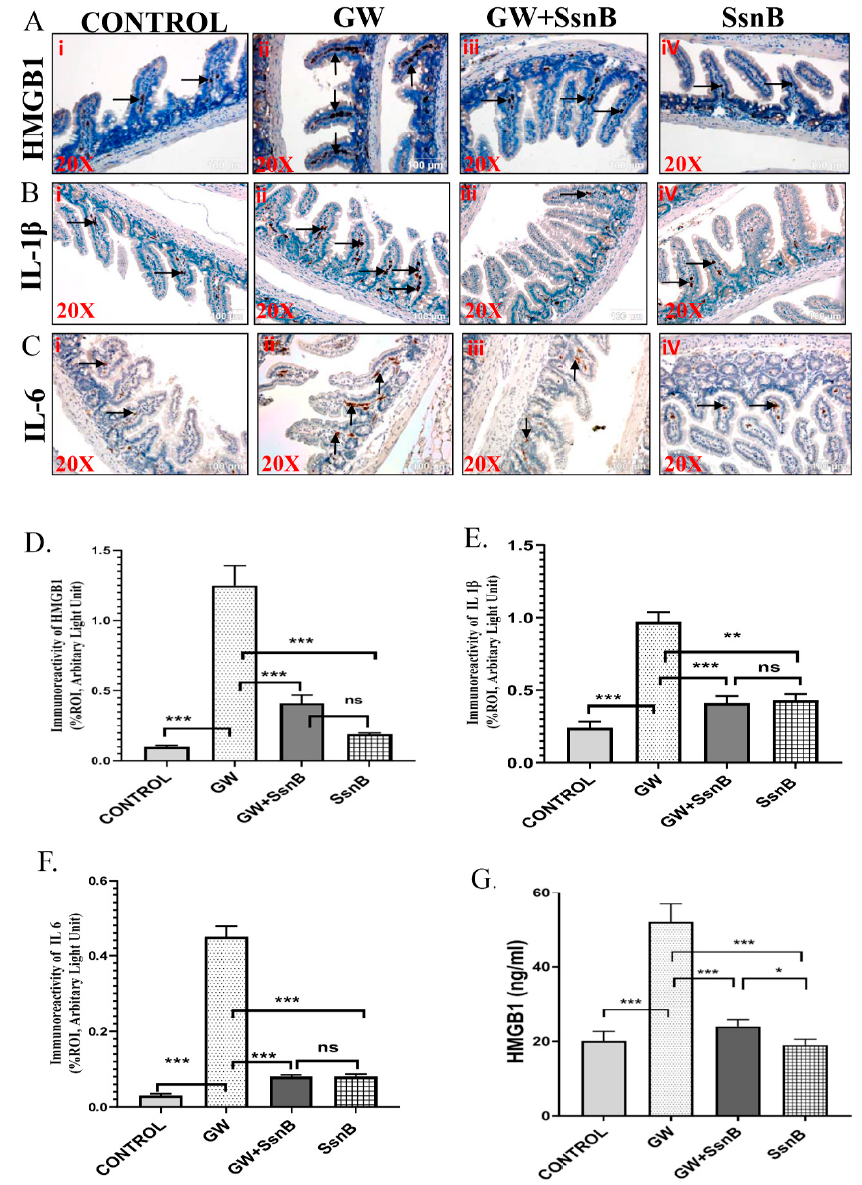
Figure 2. SsnB administration attenuates GW chemical-induced expression of pro-inflammatory cytokines and damage-associated molecular pattern high mobility group box 1 (HMGB1). Representative immunohistochemistry images of small intestine showing immunoreactivity (reactivity was majorly observed in the villi marked with black arrows) for HMGB1 (Figure 2A), IL-1 β (Figure 2B), and IL-6 (Figure 2C) in CONT ( n = 3) (wild-type mice which were treated with vehicle), GW ( n = 3) (GW chemical exposed group), GW + SsnB ( n = 3) (group exposed with GW chemicals and SsnB), and SsnB ( n = 3) (group treated with SsnB only). Images were taken in 20 × magnification. Bar graphs depicting morphometric analysis of HMGB1 (Figure 2D), IL-1 β (Figure 2E), and IL-6 (Figure 2F) immunoreactivity are represented as mean ± SD of the %ROI (mean value calculated from three separate fields of a section of the small intestine). Significance was analyzed by unpaired T-test where * p < 0.05, ** p < 0.01, *** p < 0.001. Bar graph depicting the serum HMGB1 level at ng / mL (Figure 2G). Significance was analyzed by unpaired T-test where * p < 0.05, ** p < 0.01, *** p <